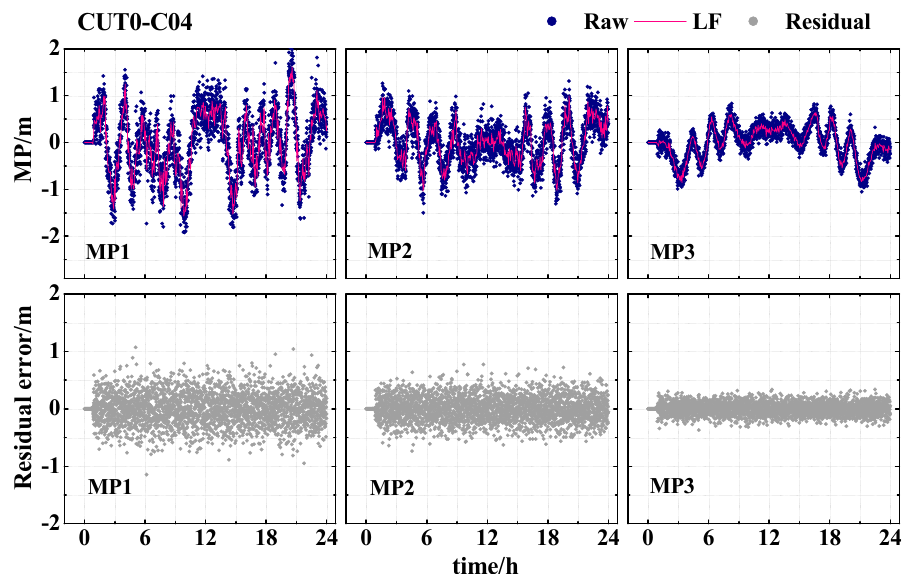
Figure 5. Wavelet analysis results of the C04 satellite at the CUT0 station for DOY 58 in 2017 (27 February 2017). “Raw” represents the original multipath series, “LF” represents the low-frequency component extracted from the multipath series, and “Residual” indicates the multipath residual series after subtracting the low-frequency component.